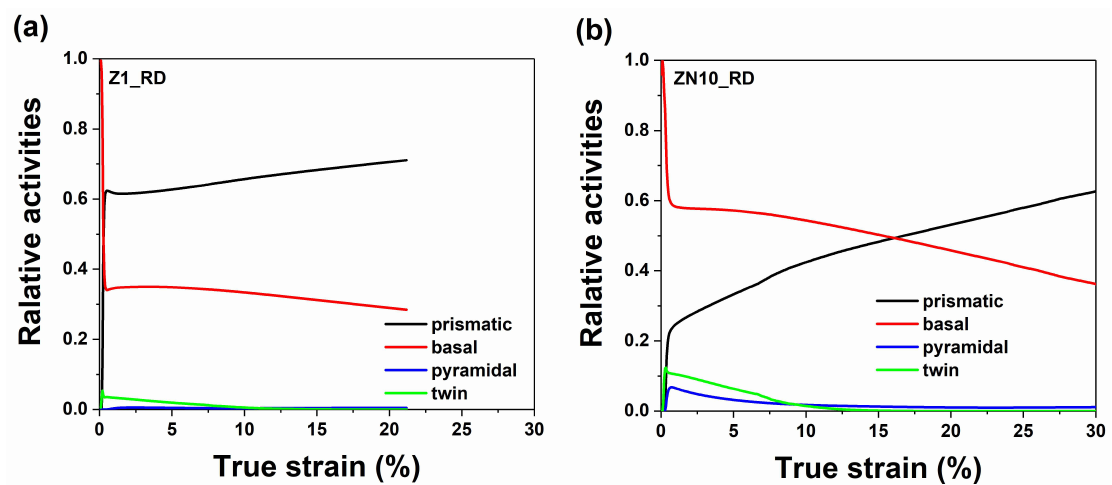
Figure 12. The relative deformation mode activities as a function of the strain: ( a ) Z1 along RD; ( b ) ZN10 along